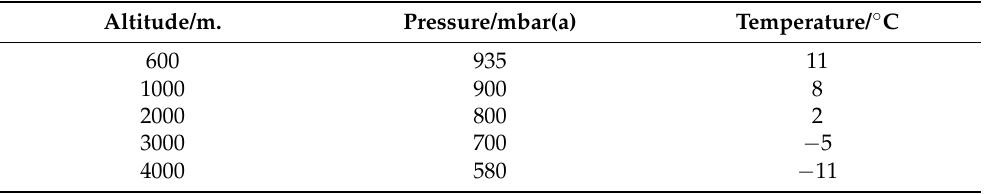
Table 1. Values used for simulated altitude, oriented towards the international standard atmosphere. Altitude/m.